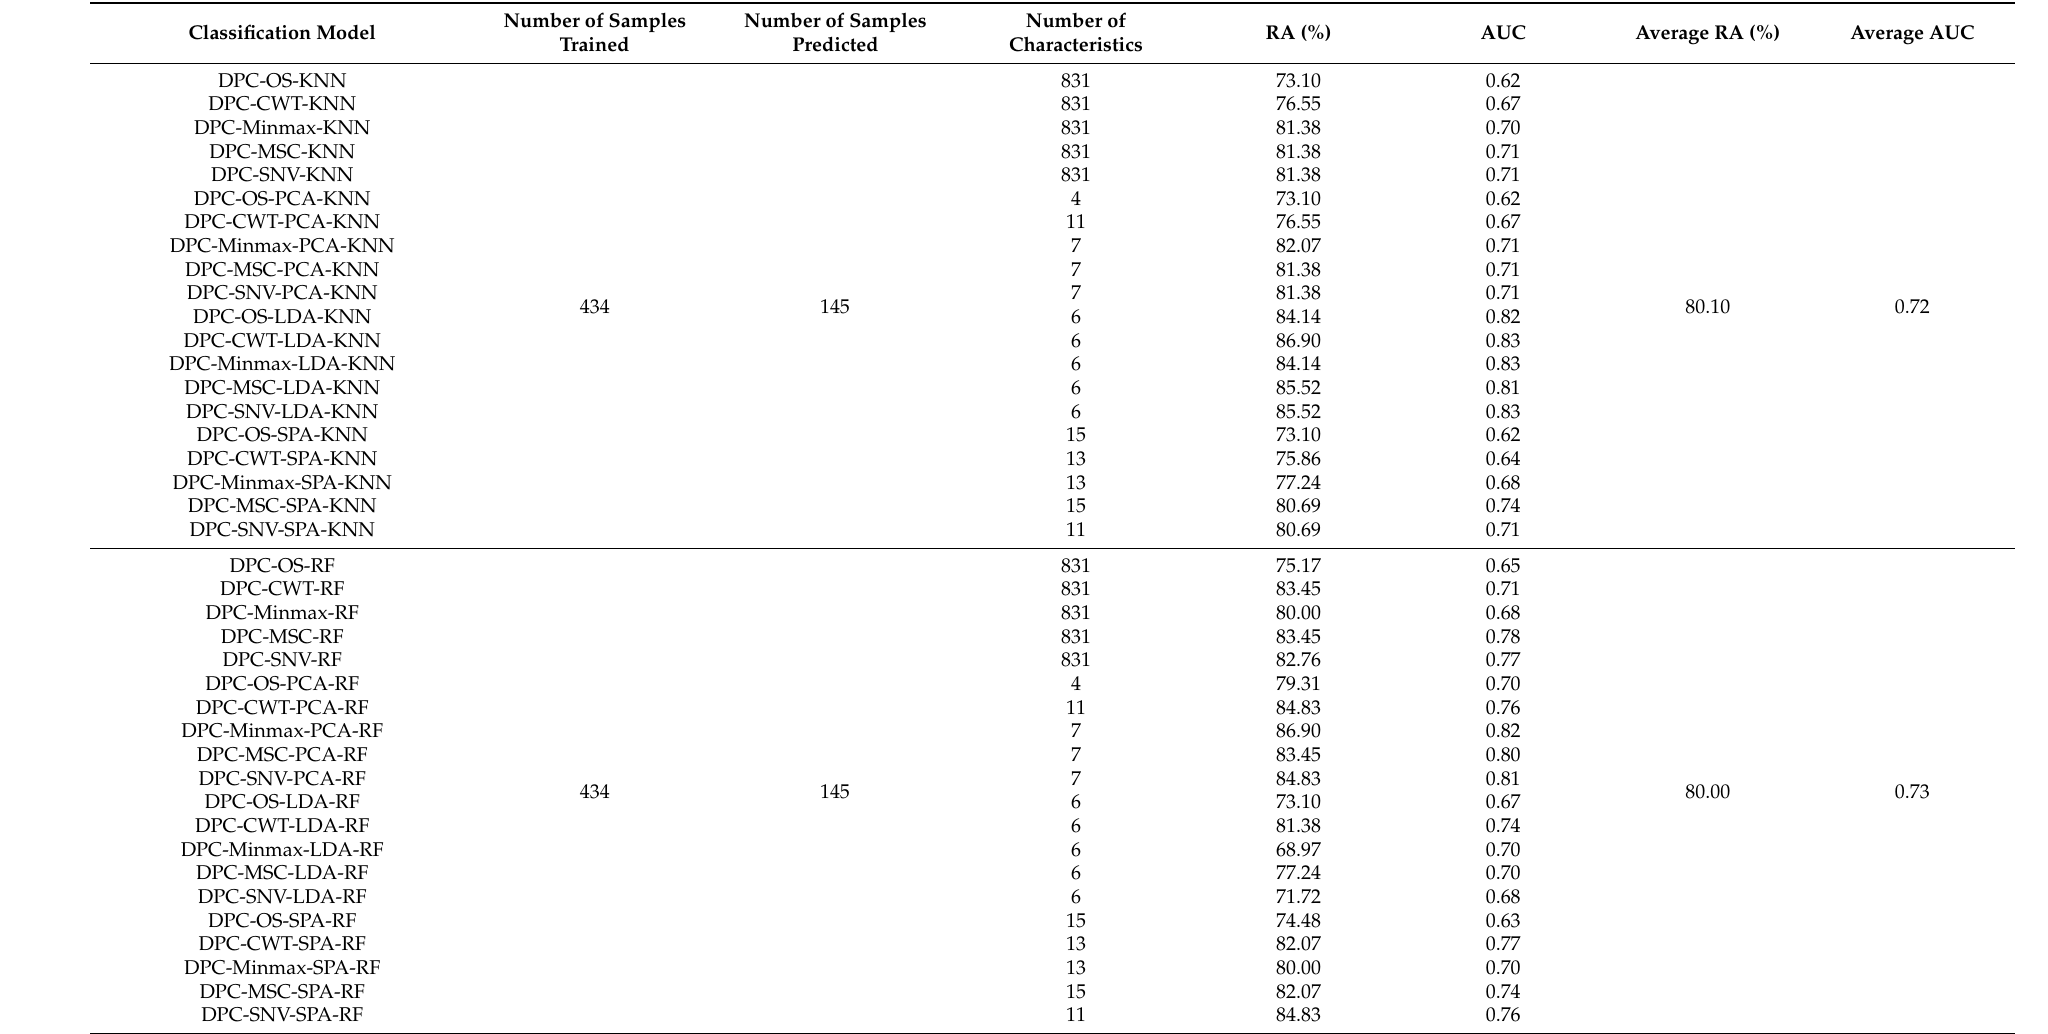
Table 2. Performance evaluation of traceability models of white tea classified by